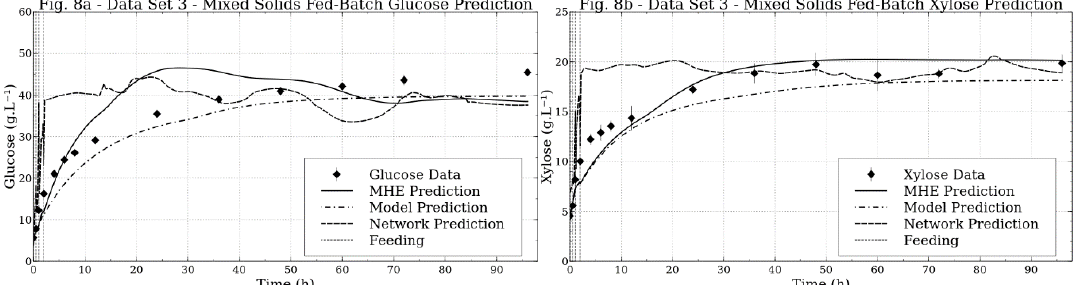
Figure 8. Fixed weights Moving Horizon Estimator (MHE) with four elements in moving window carbohydrates concentration predictions for Mixed Solids Fed-batch (MSF); top and bottom graphs are glucose and xylose predictions; error bars in data points are standard errors between experiment duplicates for compound concentration; vertical dotted lines are the biomass feeding times.